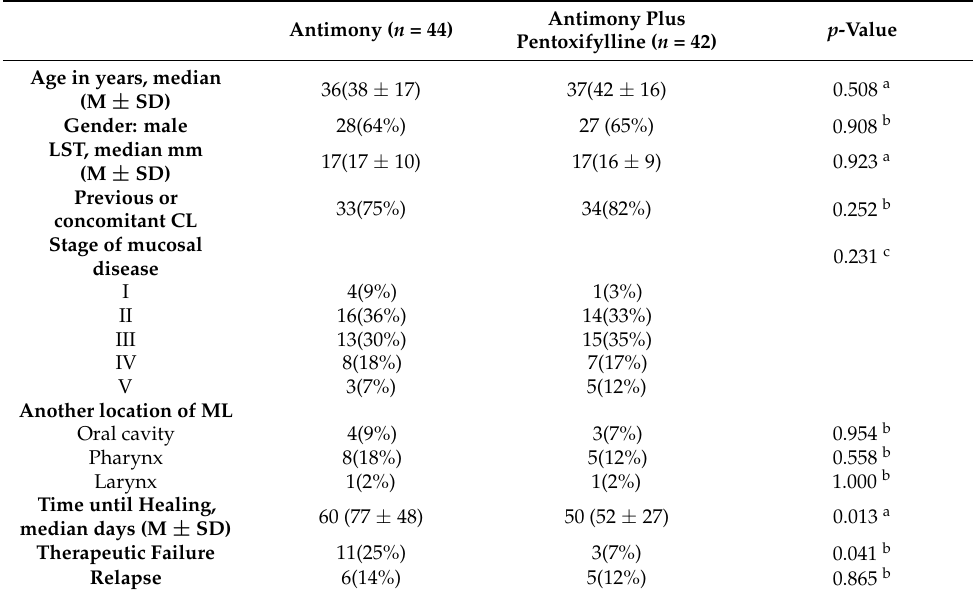
Table 1. Demographic and clinical features of patients with mucosal leishmaniasis.